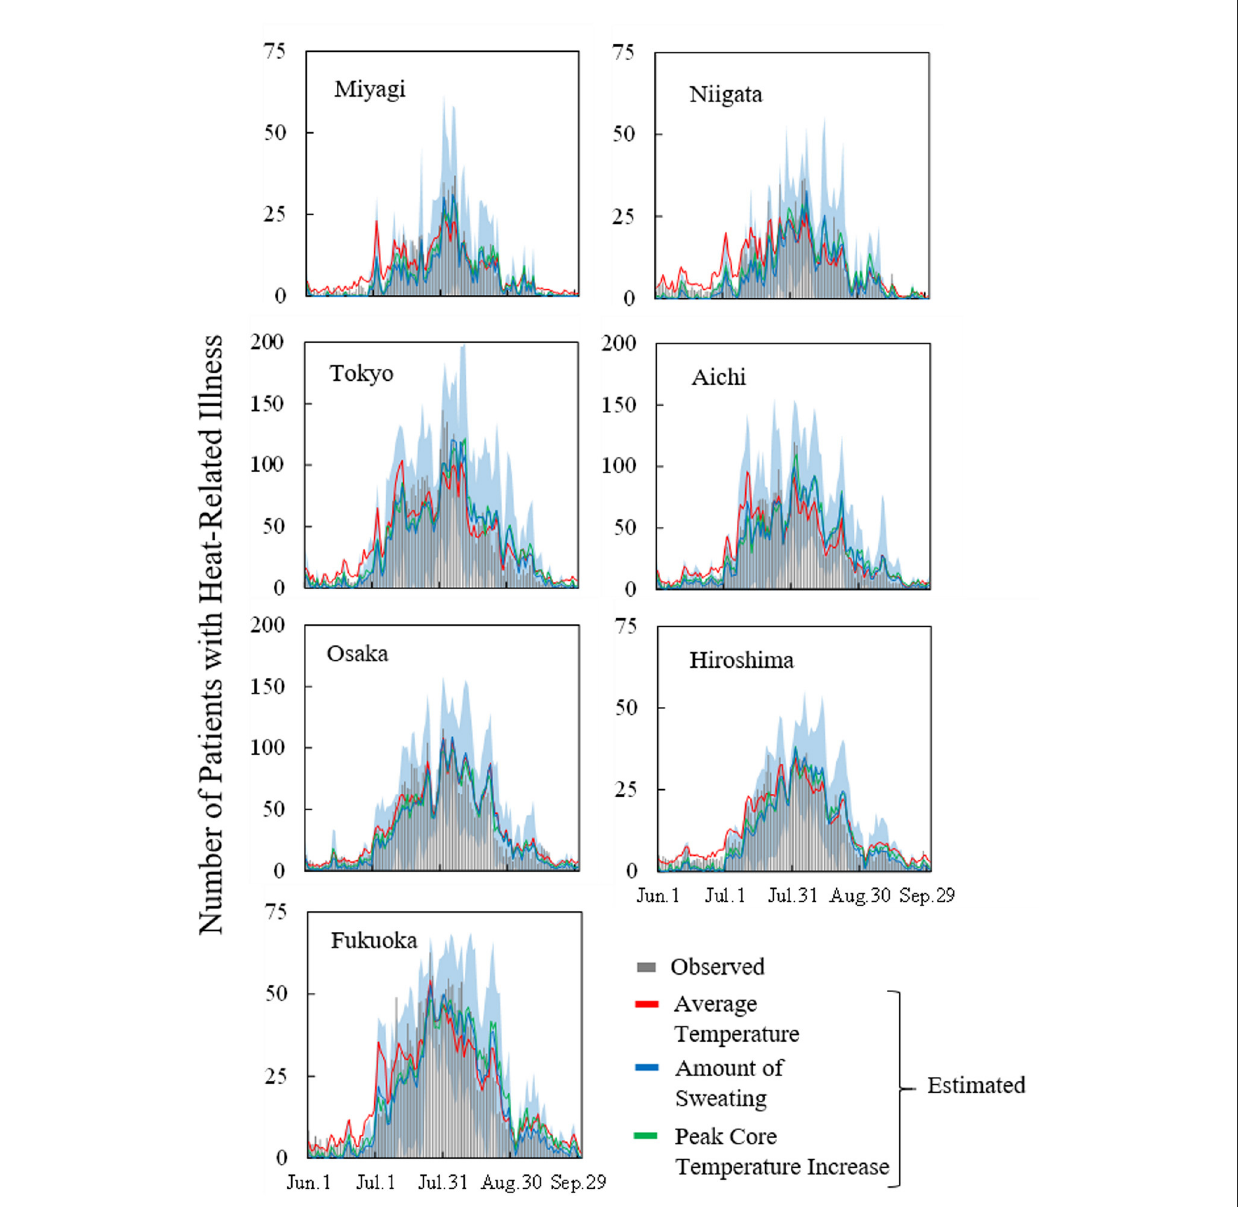
FIGURE4 Observed and estimated number of patients with heat illness in seven prefectures (averaged over the period from 2013 to 2019) for average ambient temperature, amount of sweating, and body core temperature increase. Blue region represents the 95% confidence interval of estimation using computed daily amount of